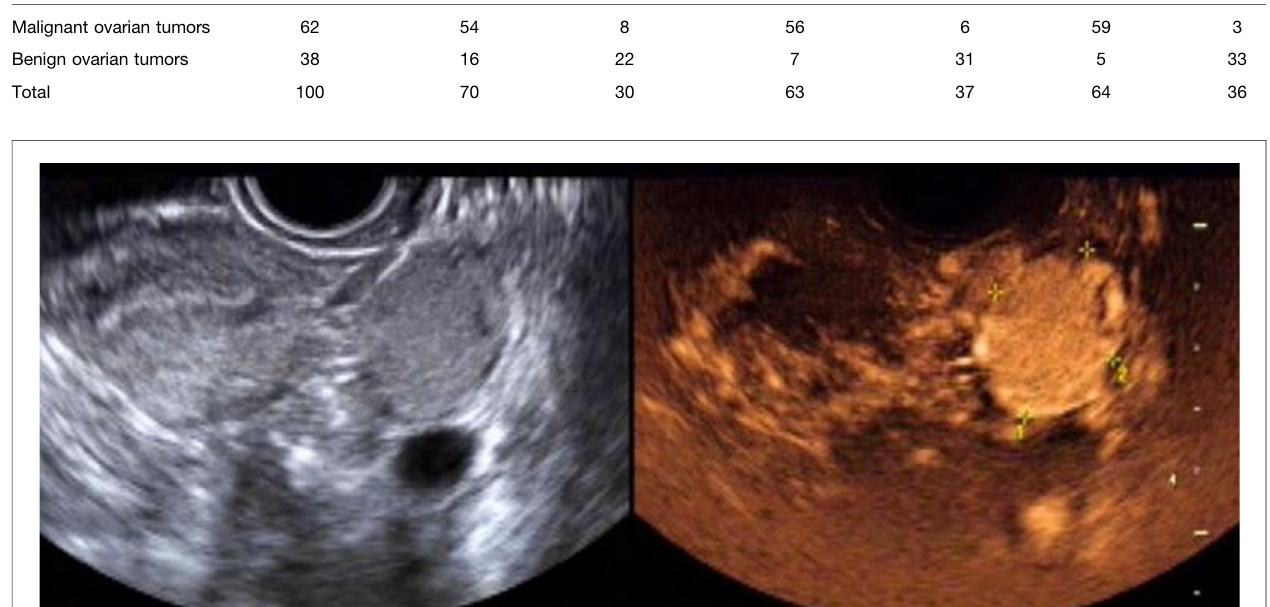
FIGURE 5 | Female patient, 26 years old. Two-dimensional transvaginal ultrasound showed a round hypoecho in the left ovary, measuring about 3.5 cm×2.4 cm× 3.1 cm, clear and regular in boundary, and uneven in internal echo. On CDFI, blood fl ow signals in the form of dots and strips were observed. According to contrast- enhanced ultrasound, the lesion in the left ovary was enhanced slightly earlier than that in the myometrium, and rapidly and integrally enhanced from multiple points in the center to the periphery, with the enhancement degree signi fi cantly higher than that in the myometrium. The lesion was cleared away from the center to the periphery, presenting as “ fast forward and slow reverse ” . The capsule echo appeared to be seen from the lesion in the early fi lling and late